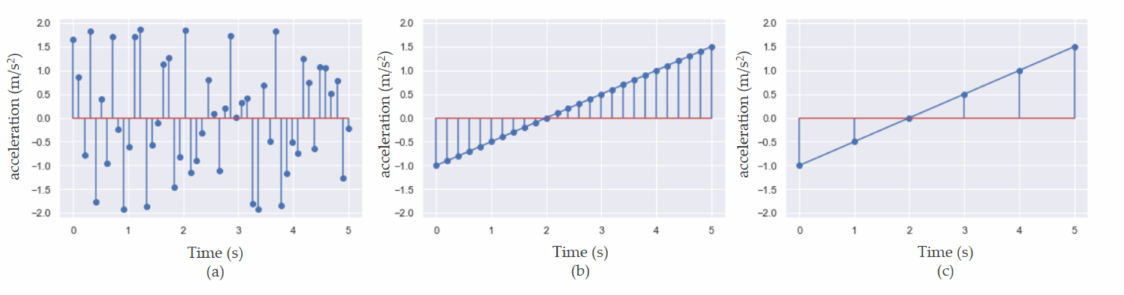
Figure 8. ( a ) Not a plausible vehicle acceleration and result in an error during the learning process. ( b ) A plausible vehicle acceleration. However, 26 numbers are used to represent this simple line. ( c ) This represents the same vehicle acceleration. It uses only six numbers and likely a better parameterization of this acceleration